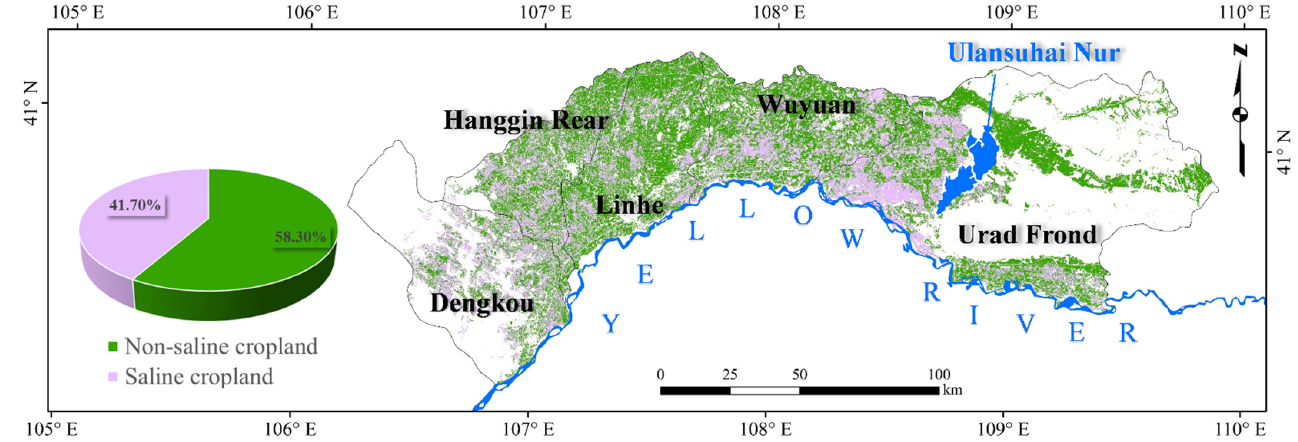
Figure 6. The distribution of non-saline and saline cropland with the percentage pie chart.